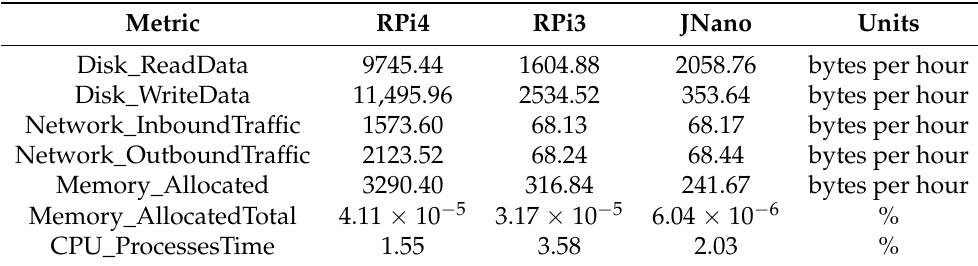
Table 2. Metrics of the implemented blockchain by